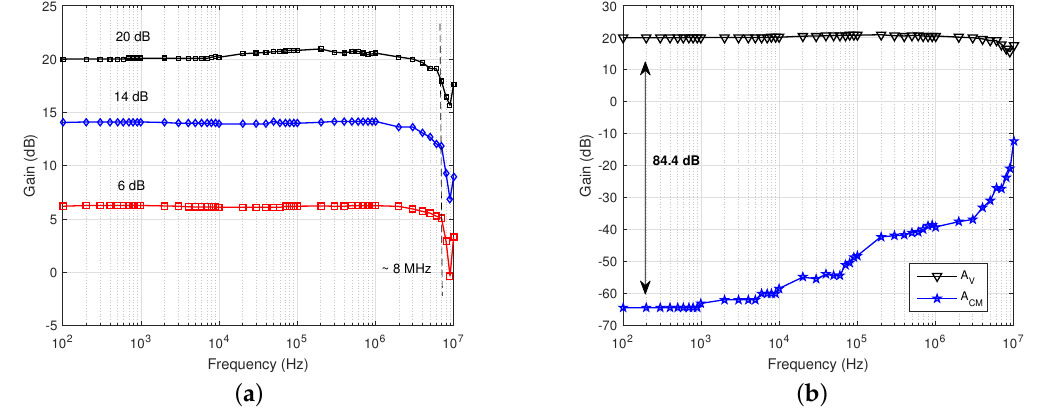
Figure 15. Measured ( a ) frequency response and ( b ) CMRR at 20 dB of the INA.